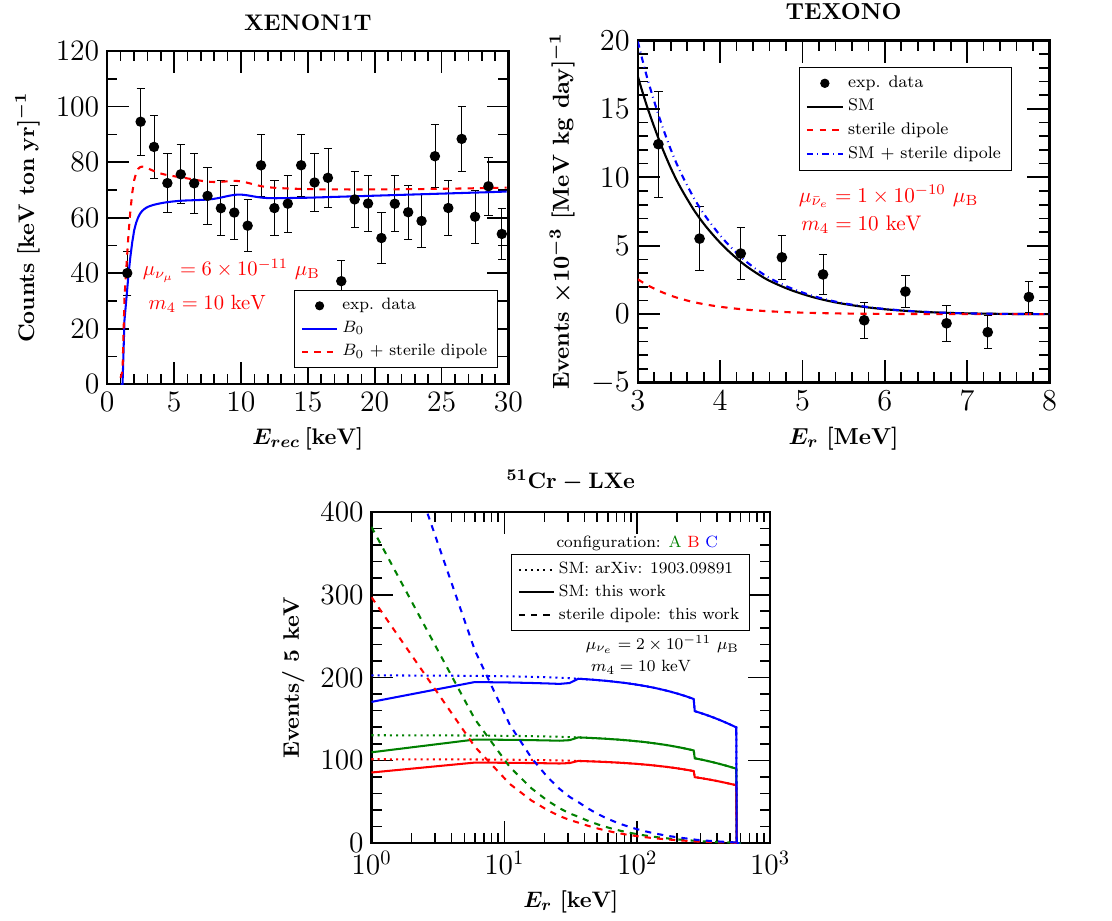
Figure 1 . Signal at XENON1T (top left) assuming µ ν assuming µ ¯ ν = 1 × 10 − 10 µ B and Cr-LXe (bottom) assuming µ ν e correspond to a sterile neutrino with mass m 4 =10